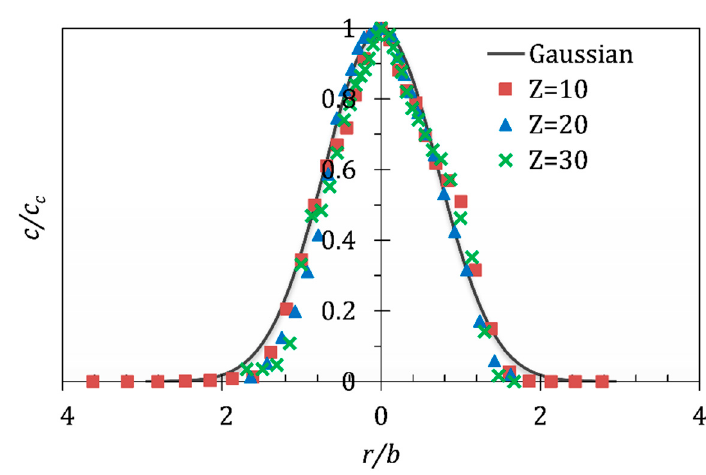
Figure 10. Gaussian and simulated concentration profile of the jet on the horizontal plane.